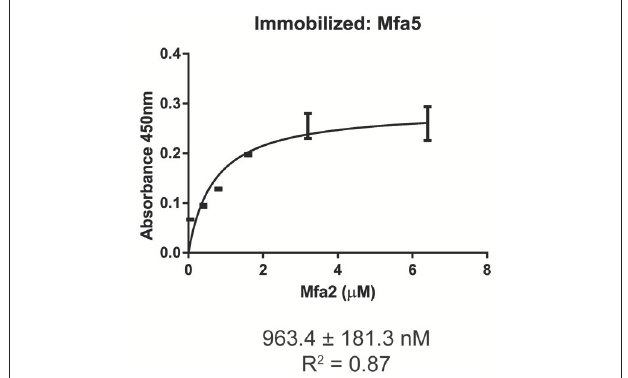
FIGURE 2 | ELISA of binding between Mfa2 and Mfa5. Mfa5 (1 µ g) was immobilized on a microtiter plate. Binding of recombinant Mfa2 at the concentrations indicated was detected with antibodies to Mfa2 (1:5,000) followed by secondary anti-rabbit IgG HRP-linked antibodies (1:5,000). Signals were developed with the TMB substrate and absorbance values were measured at 450nm. The binding data were analyzed using a 1:1 saturation binding model, and K D and R 2 values are shown. The data are from 3 independent experiments.